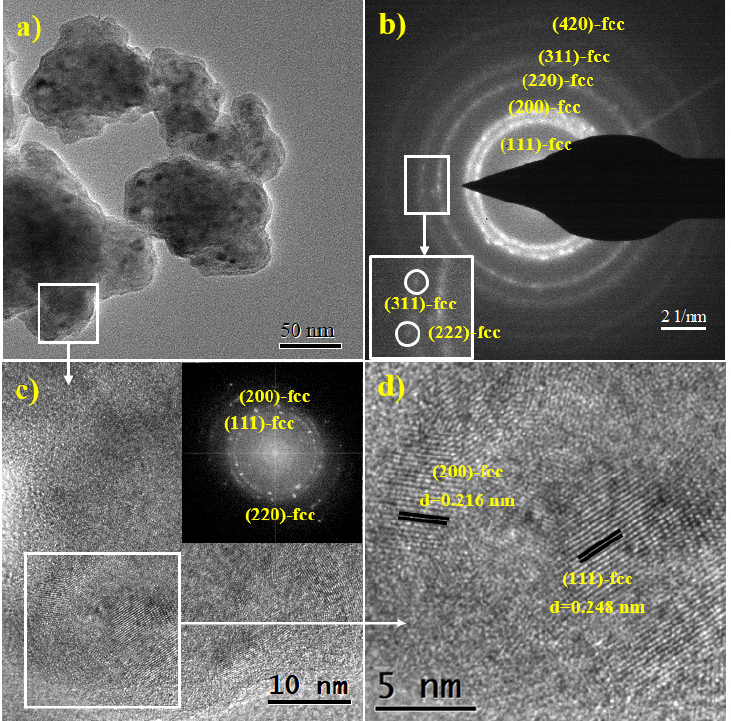
Figure 9. Transmission electron microscopy (TEM) study for the TiNb15Mn alloy milled after 24 h in the 8000D mixer/mill ® (SP10_24h). ( a ) TEM image; ( b ) electron diffraction (ED) image; ( c ) and ( d ) high-resolution TEM images; inset in ( c ) the corresponding FFT